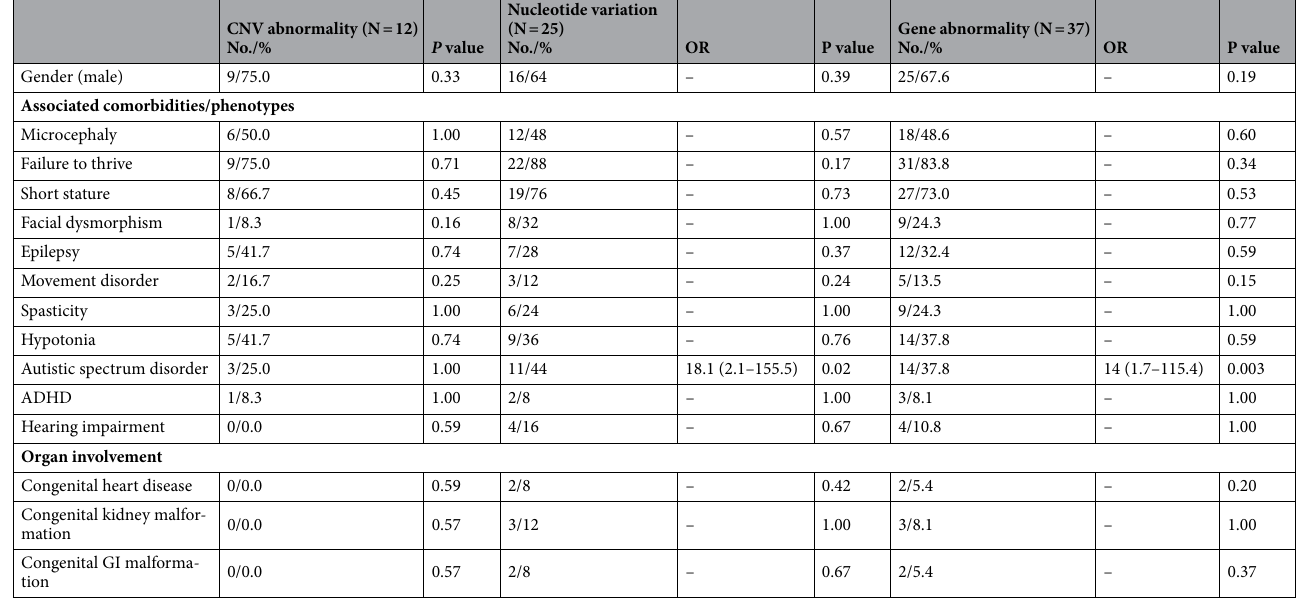
Table 2. Risk to genetic abnormality by CMA and/or WES. ADHD attention-deficit hyperactivity disorder, CNV copy-number variation, OR (95% CI) Odds ratio (95% confidence interval), WES whole-exome sequencing.